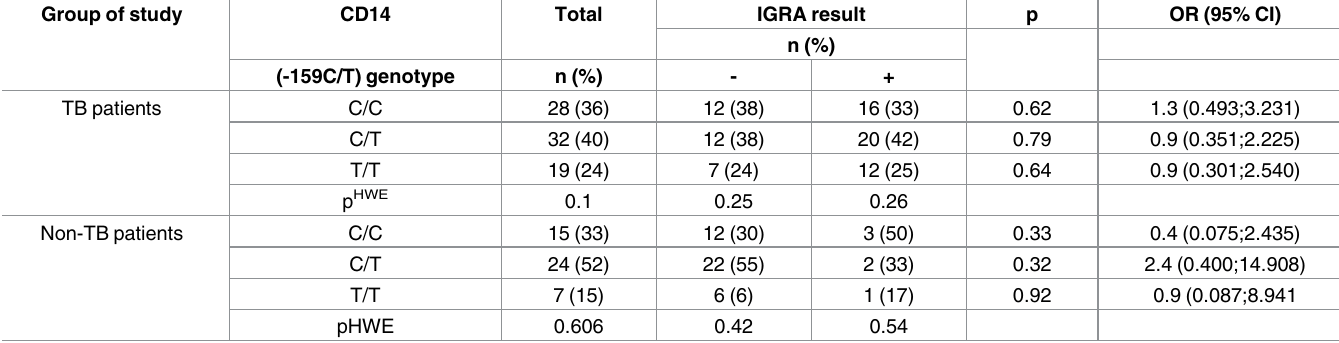
Table 5. Frequency of CD14(-159C/T) genotypes in IGRA(-) and IGRA(+) individuals from TB and non-TB groups.